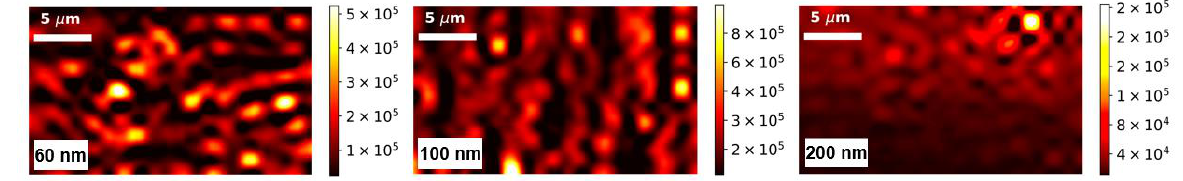
Figure 8. Raman spectral maps of the H 2 Pc* molecules on SERS substrates with different NW diameters plotted over the full area under the spectra from 500 to 1800 cm − 1 . The quality of SERS-active surfaces can also be assessed using characteristic histograms.